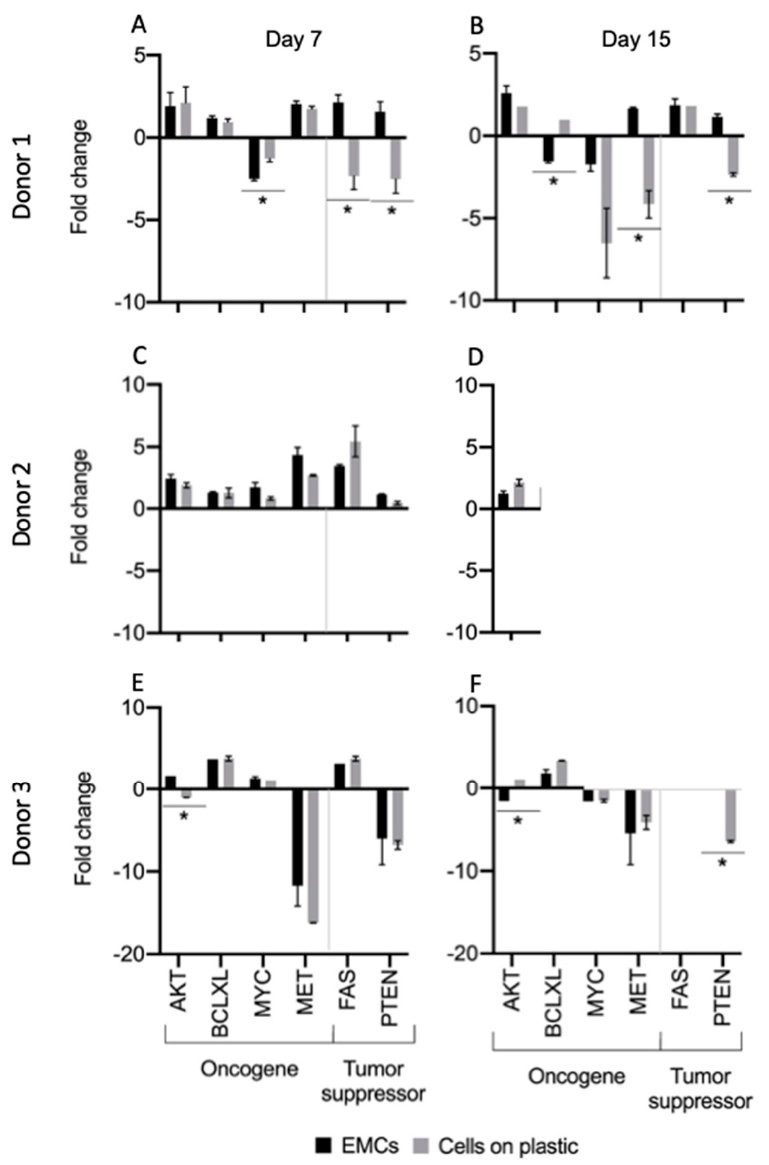
Figure 3. The gene expression pattern of primary carcinoma cells derived from human bladder carcinoma seeded on bladder scaffolds (EMCs) was similar to the profile of the original carcinoma on day 0 and to the pattern of the same cells seeded on plastic. Primary epithelial cells from bladder carcinoma isolated from: ( A , B ) donor 1, ( C , D ) donor 2, and ( E , F ), donor 3 on days 7 and 15. The fold change of samples was compared with the original bladder carcinoma on day 0. * Statistically significant p ≤ 0.05.